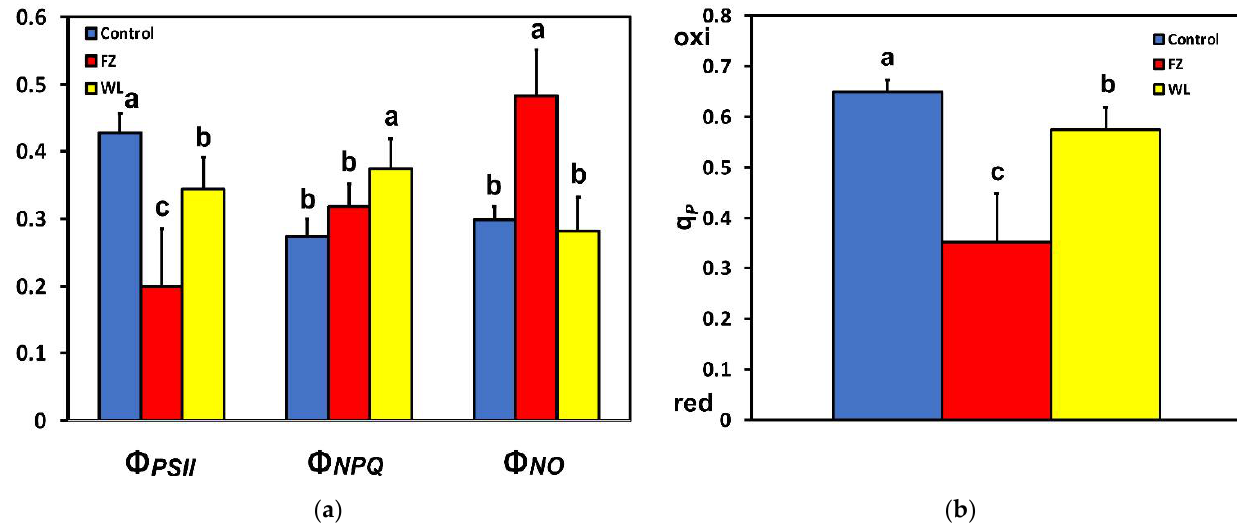
Figure 2. Changes in ( a ) the effective quantum yield of PSII photochemistry(Φ PSΙΙ ), the quantum yield of regulated non- photochemical energy loss in PSII (Φ NPQ ), and the quantum yield of non-regulated energy loss in PSII (Φ NO ); and in ( b ) the fraction of open PSII reaction centers (q p ) at the whole leaflet level before feeding (control), at the feeding zone after feeding (FZ), and at the whole leaflet after feeding (WL). Error bars are standard deviations. Columns with different letters are statistically different ( p < 0.05).